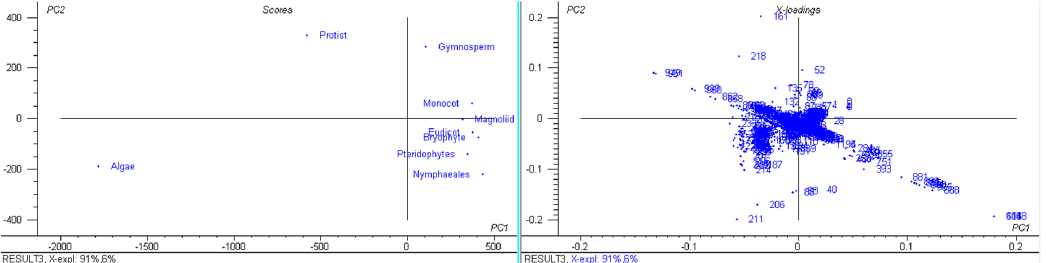
Figure 3. Principal component analysis of CDS numbers of chloroplast genomes. The CDS number of algae, gymnosperms, and protists fall separately; however, bryophytes, eudicots, pteridophytes, and Nymphaeales fall together.